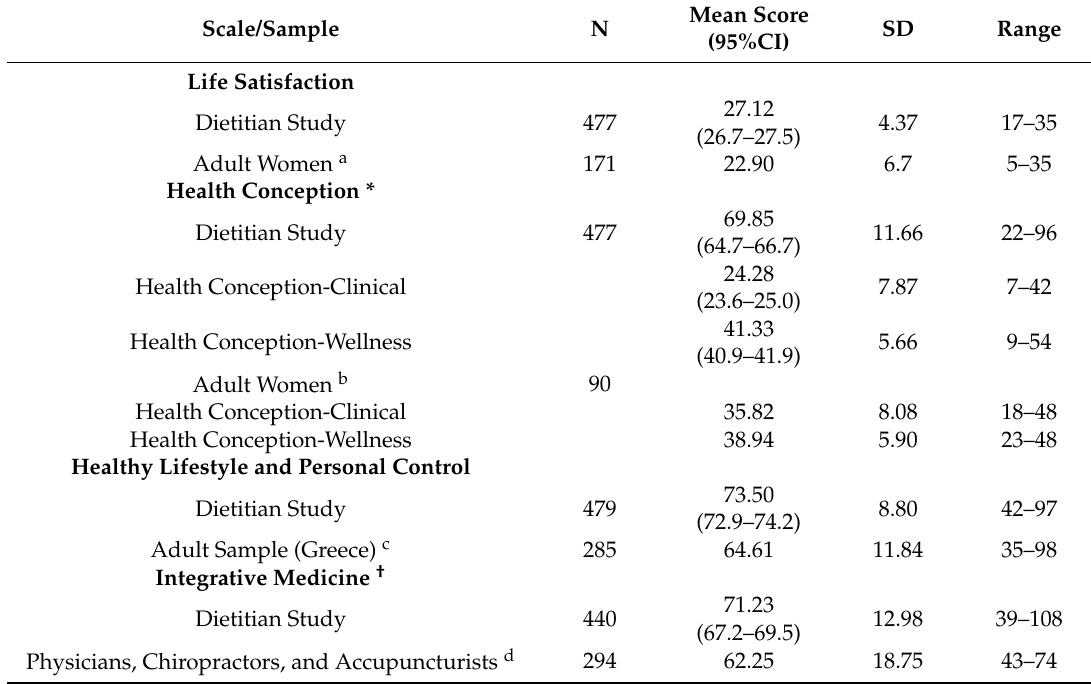
Table 2. Normative data for satisfaction with life, health conception, healthy lifestyle, and integrative medicine scales.